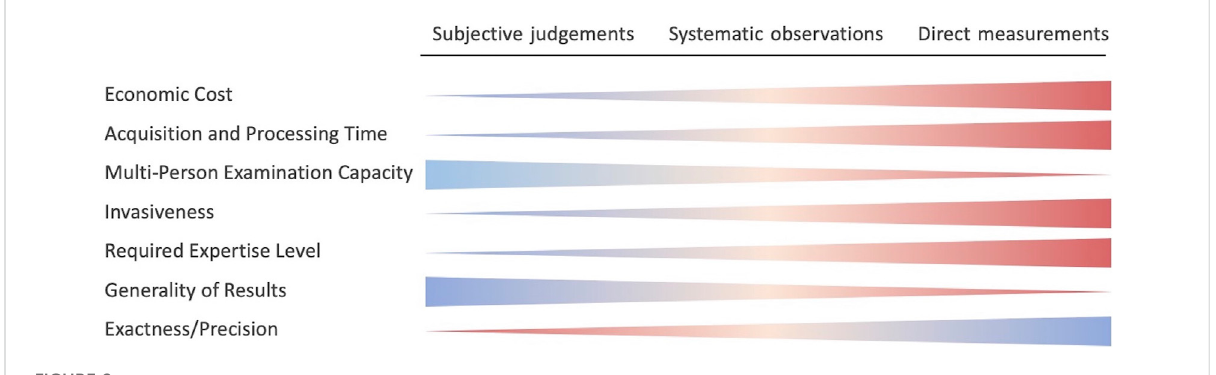
FIGURE 2 Overview of trade-offs among the different categories of methods for the assessment of physical and cognitive workload. The variation in thickness indicates the feature trend, while the colours re fl ect the positive (blue) or negative (red)